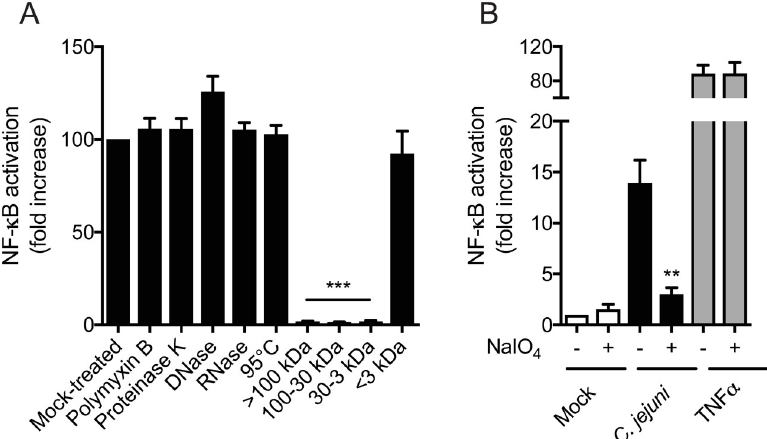
Fig 2. Molecular characterization of the C . jejuni -released proinflammatory factor. (A) HeLa 57A cells were stimulated with sterile conditioned culture medium that was either mock-treated, pre-treated with polymyxin B, proteinase K, DNase, or RNase at 37˚C for 1 h, incubated at 95˚C for 10 min, or separated based on size using 100 kDa, 30 kDa and 3 kDa cut-off filters prior to cell stimulation. (B) C . jejuni conditioned culture medium or TNF α were treated with 10 mM sodium periodate (NaIO 4 ) or mock-treated prior to stimulation of HeLa 57A cells. NF- κ B activation is measured as relative luciferase units and presented as fold increase in stimulated versus unstimulated cells. Values represent the mean ± SEM of three independent experiments performed in duplicate. � p < 0.05, �� p < 0.01, and ��� p < 0.001.